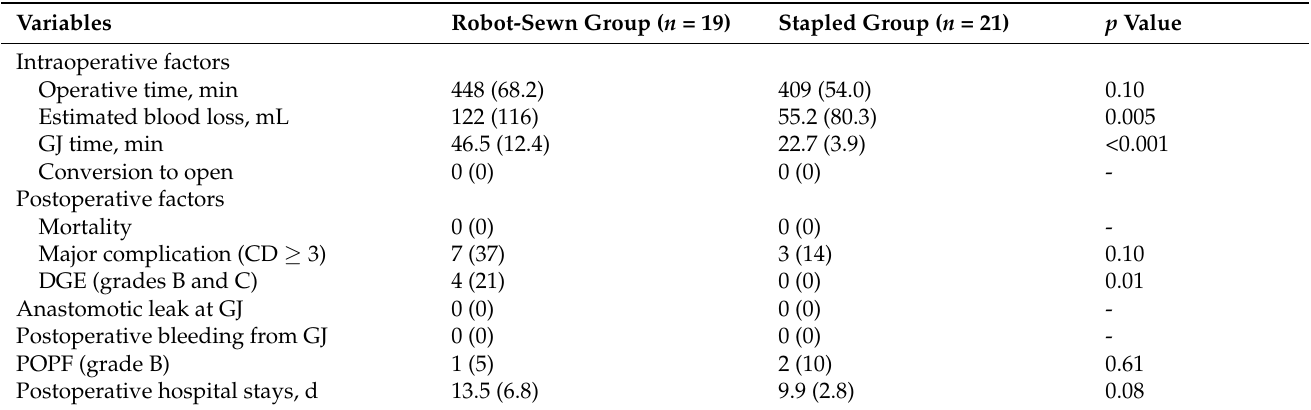
Table 2. Outcomes between robot-sewn and stapled gastrojejunostomy anastomosis in robotic